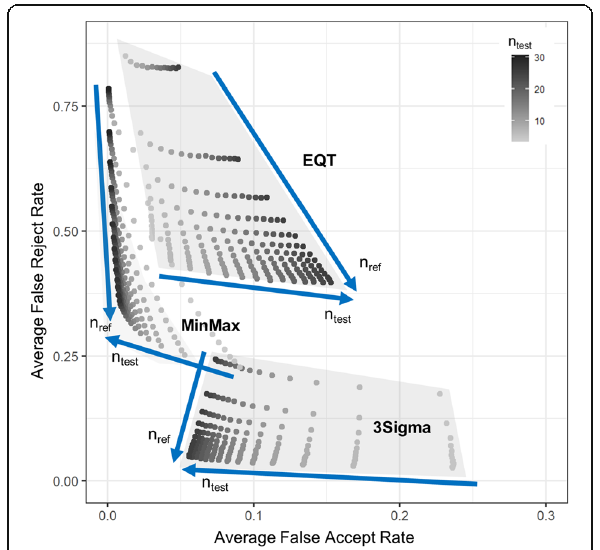
Fig. 4 Sample size dependency of average operating characteristics (Tolerance Interval): The average operating characteristics are shown for different test and reference product sample sizes (n ref = 4,6,8,...,30, n test = 4,6,8,...30) for the test Tolerance Interval. Arrows indicate the effect of increasing test product and reference product sample size (annotated as n test and n ref , respectively). In contrast to Fig. 3, the x- axis for the false acceptance rates is extended in order to visualize all data